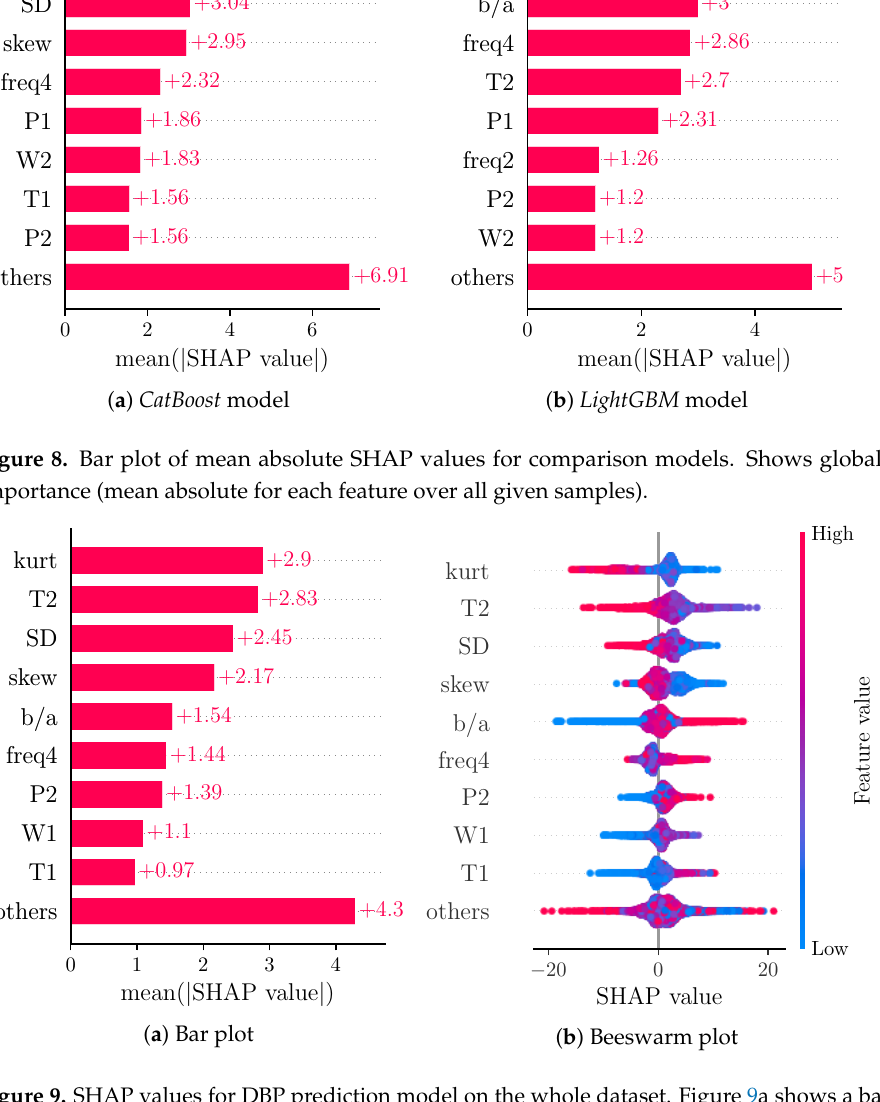
Figure 9. SHAP values for DBP prediction model on the whole dataset. Figure 9a shows a bar plot of mean absolute SHAP values that indicates global feature importance (mean absolute for each feature over all given samples). Figure 9b depicts a beeswarm plot of SHAP values. For each sample this plot shows a dot on each feature row. The features are ordered according to the mean absolute SHAP values for each feature. Depicted are the nine features with the highest mean absolute SHAP value and the sum of the remaining